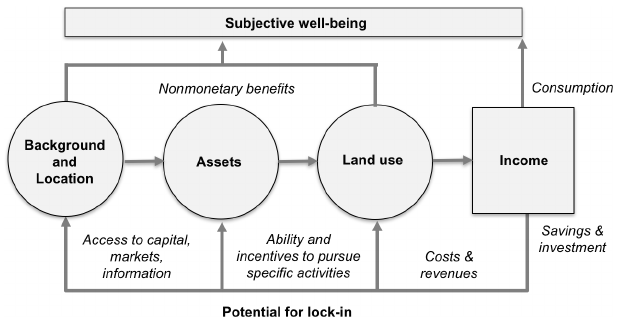
Fig. 2 . Factors that influence the subjective well-being of